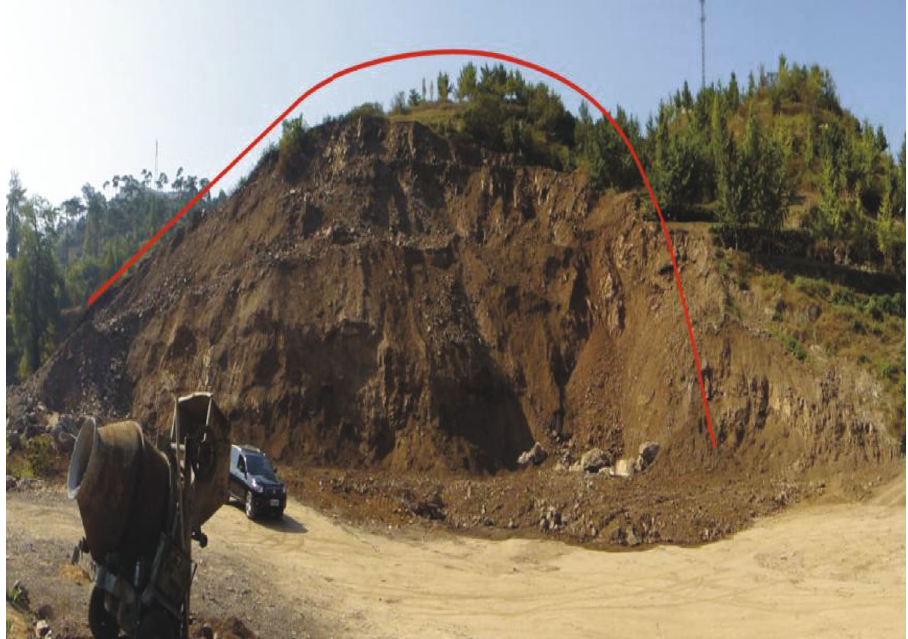
Figure 2: Overall view of the Shangge Village